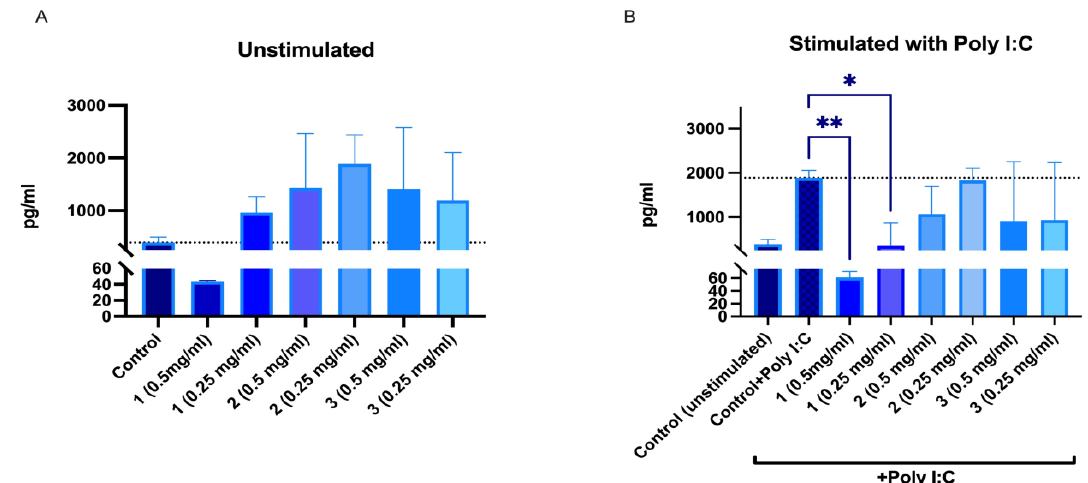
Figure 10. Changes in IL-8 secretion from unstimulated ( A ) and poly-I:C-stimulated ( B ) human peripheral blood mononuclear cells after 24 h incubation with SBT samples: 1—PACs, 2—50% EtOH extract, 3—water extract. * p < 0.05, ** p < 0.01 one-way ANOVA, n = 3. The dotted line corresponds to the control level.